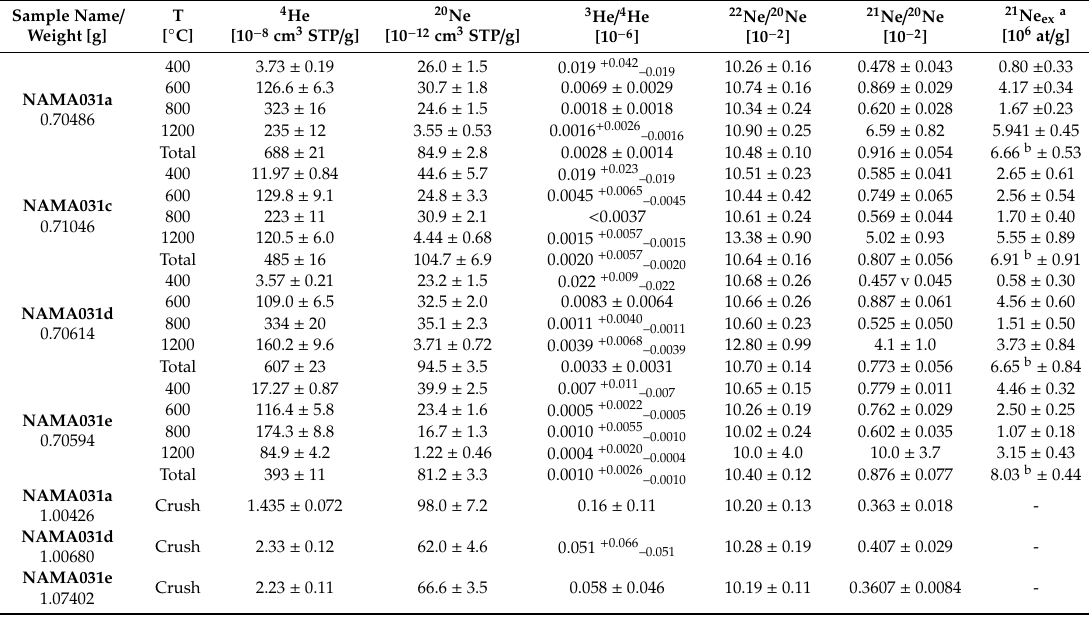
Table 3. He and Ne data. Uncertainties are 2